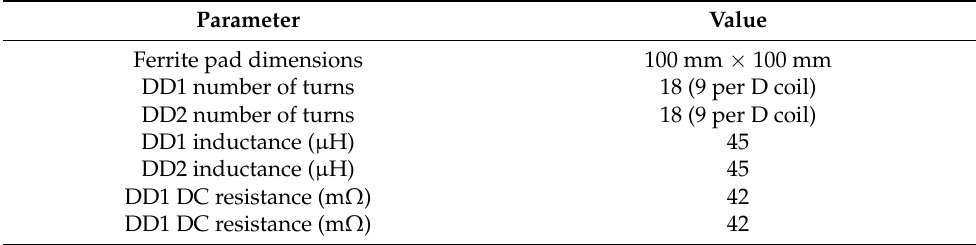
Table 1. Transmission pad parameters.